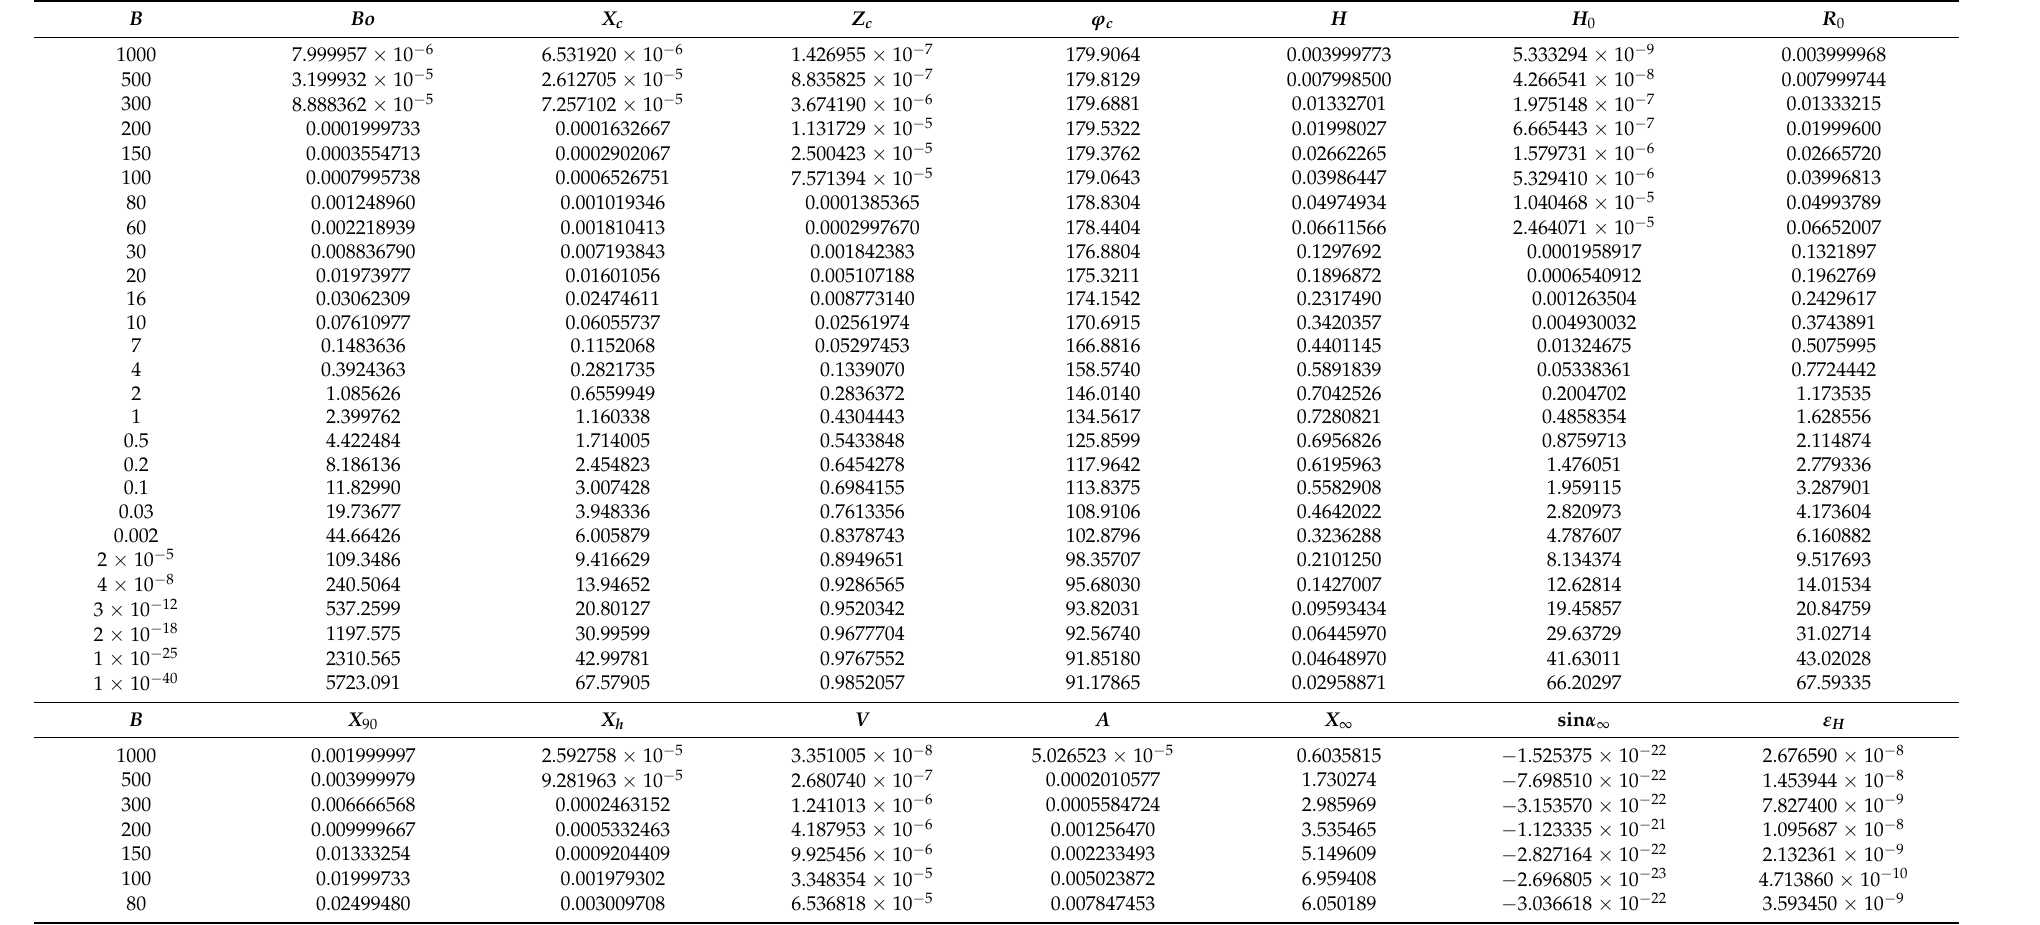
Table 4. The present numerical results for important bubble